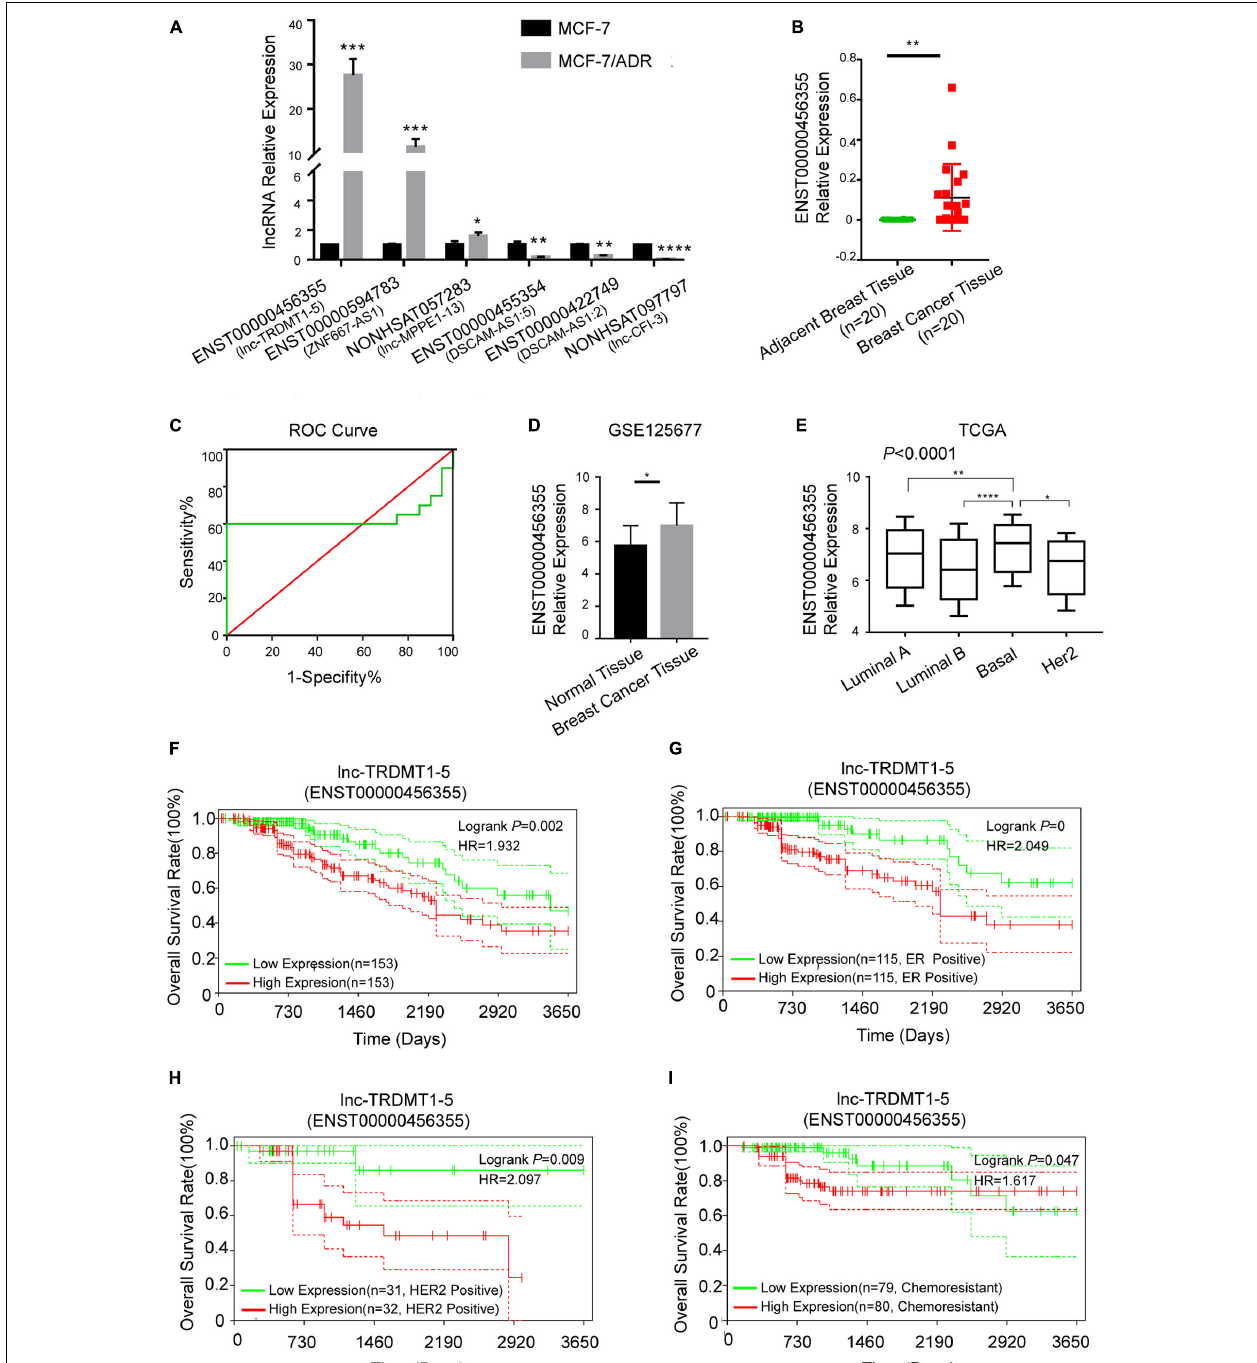
FIGURE 5 | Lnc-TRDMT1-5 was upregulated in BC and could serve as a vital biomarker. (A) Quantitative PCR analysis of the six hub lncRNAs was performed to identify significant differences between MCF-7/ADR and MCF-7 cells. (B) The expression level of lnc-TRDMT1-5 was increased in BC tissues ( n = 20) compared to adjacent tissues ( n = 20). (C) ROC curve analysis of lnc-TRDMT1-5 expression in the 20 pairs of BC samples. The abscissa indicates 100% specificity, and the ordinate indicates sensitivity. (D) The expression level of lnc-TRDMT1-5 in BC tissues was compared to that in normal tissues from the GSE125677. (E) Differential expression levels of lnc-TRDMT1-5 in four molecular subtypes of BC from the TCGA database (588 invasive BC tissue samples and 55 normal samples). (F) Kaplan-Meier survival curves for lnc-TRDMT1-5 in BC patients whose follow-up data and the lnc-TRDMT1-5 expression data were available ( n = 306). (G) Survival curves for ER + BC patients ( n = 230). (H) Survival curves for HER2 + patients ( n = 63). (I) Survival curves for chemoresistant patients ( n = 159). Horizontal axis: survival time (days); vertical axis: survival rate. HR: Hazard ratio. Red and blue dashed lines in the figure indicate confidence intervals. * P < 0.05, ** P < 0.01, **** P <